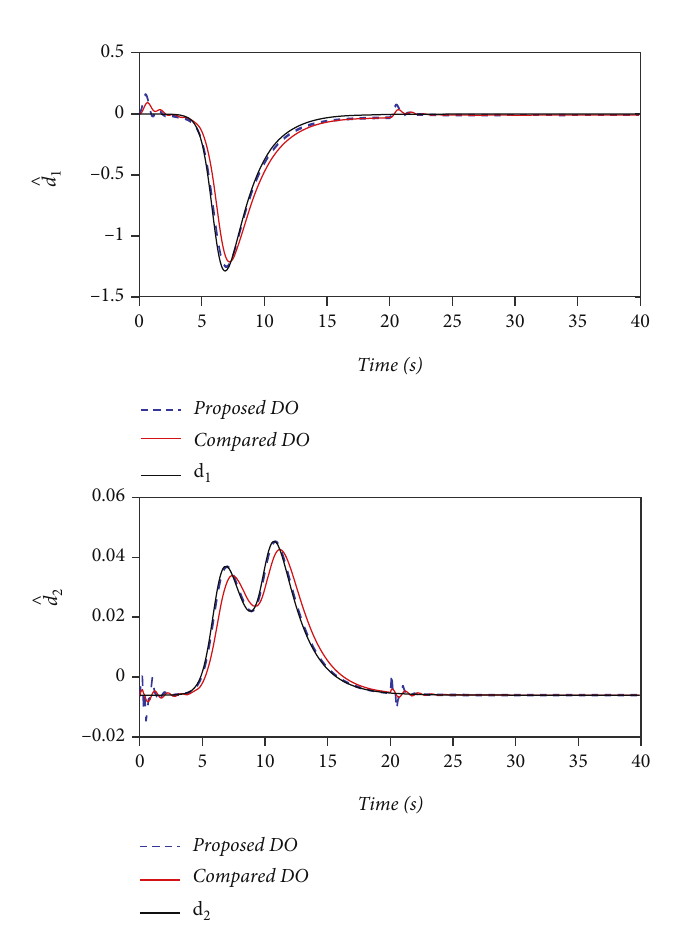
Figure 1: The curves of wind disturbance.